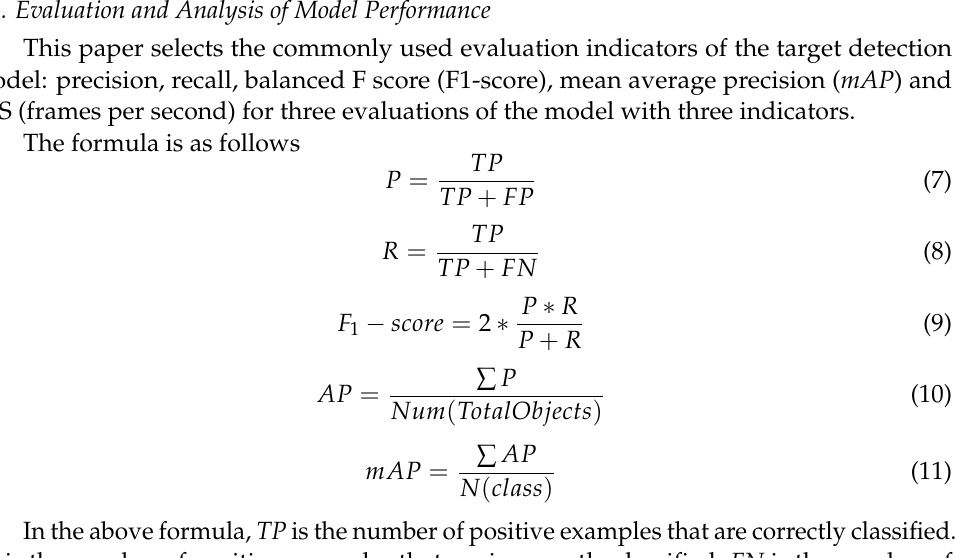
Figure 8. Comparison of the epoch process of the two models. Note: the experiment mainly seeks to compress the model and reduce the space occupied by the model, so it is normal to have a certain impact on precision and function loss.